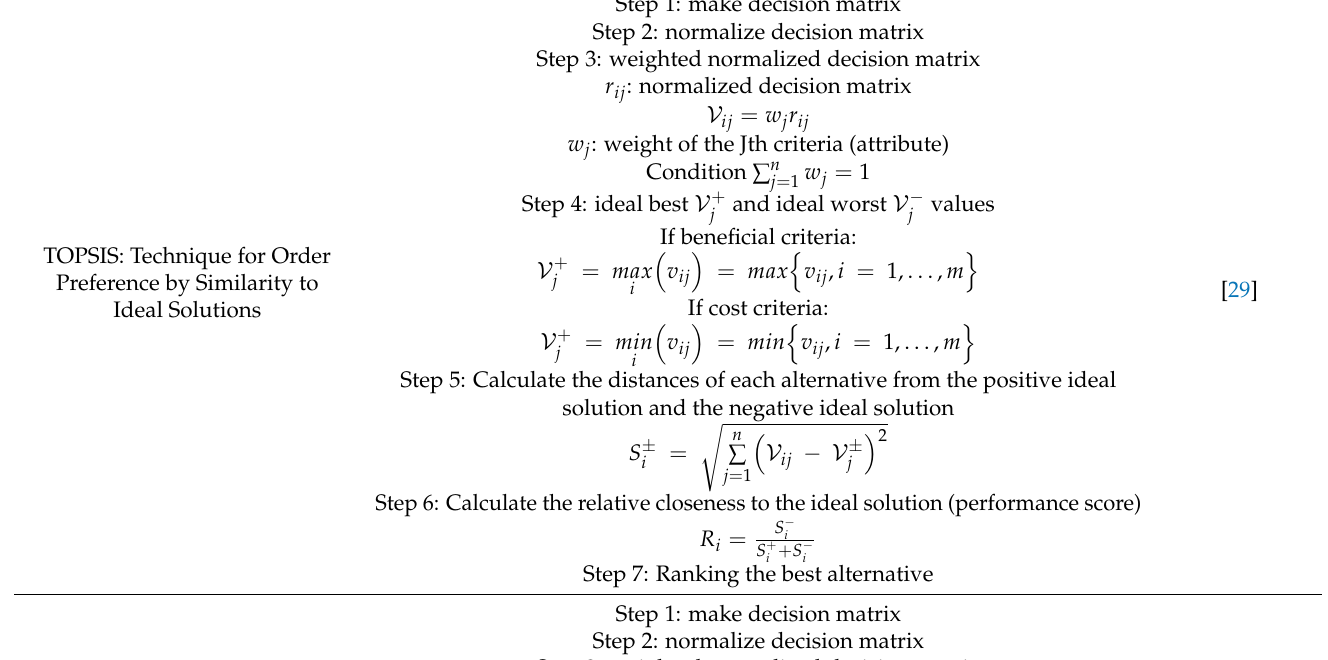
TOPSIS: Technique for Order Preference by Similarity to Ideal